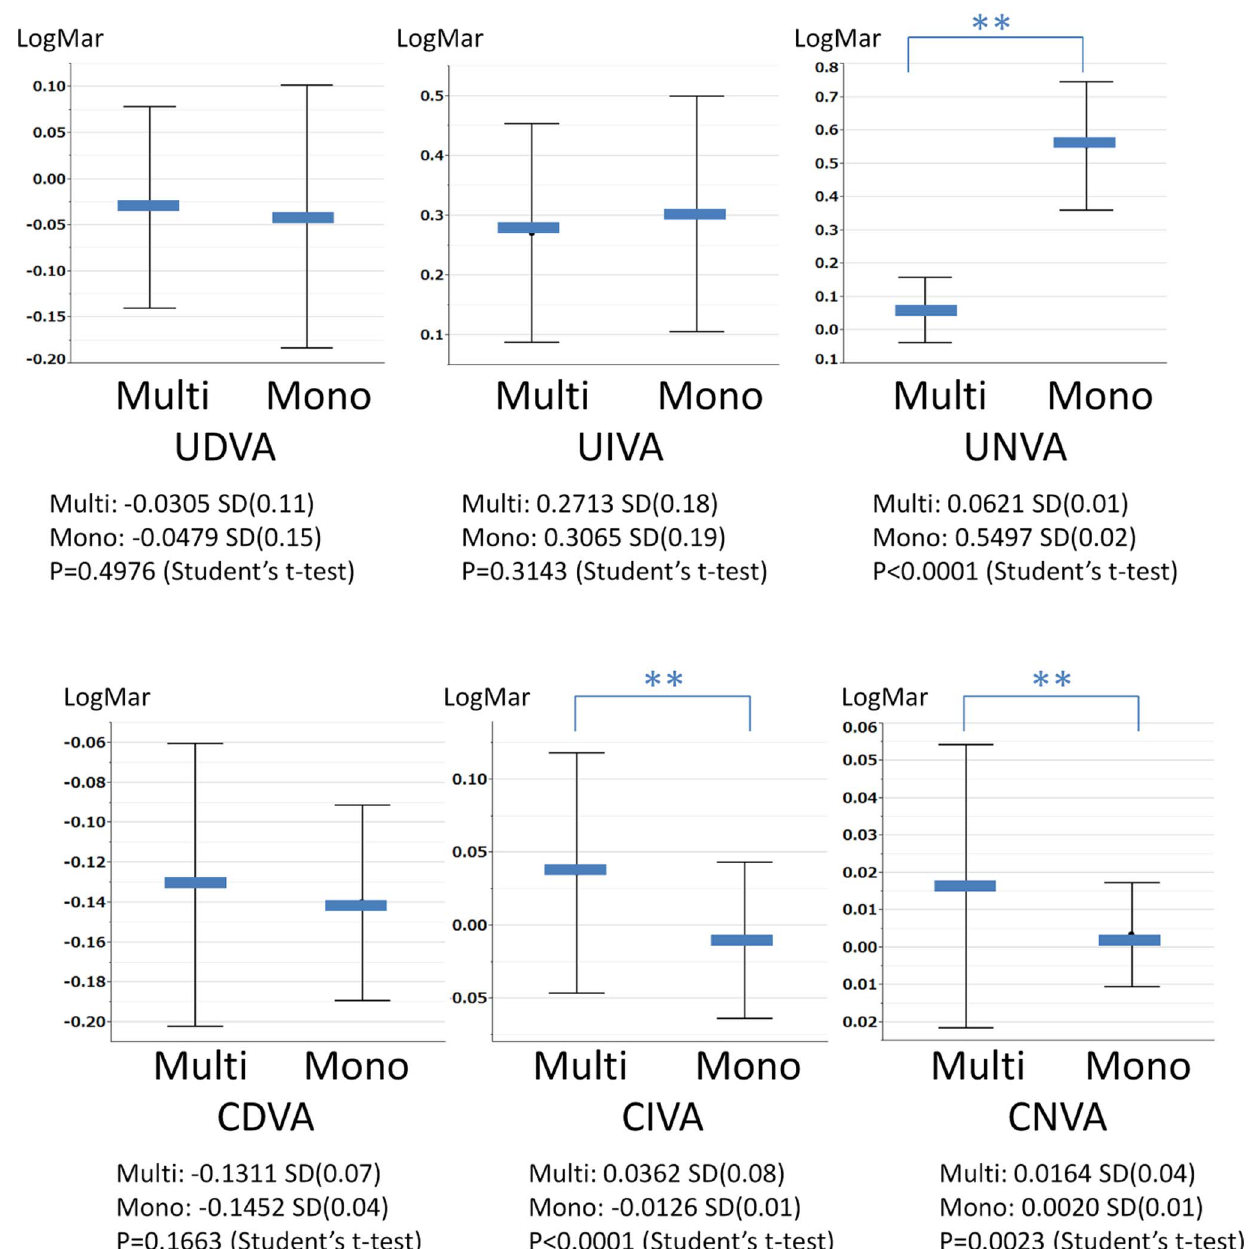
Figure 1. Uncorrected and corrected visual acuity of the multifocal and monofocal groups (mean 6 SD).